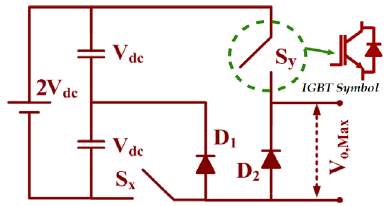
Table 1. Switching Sequence of the Proposed Basic Module.